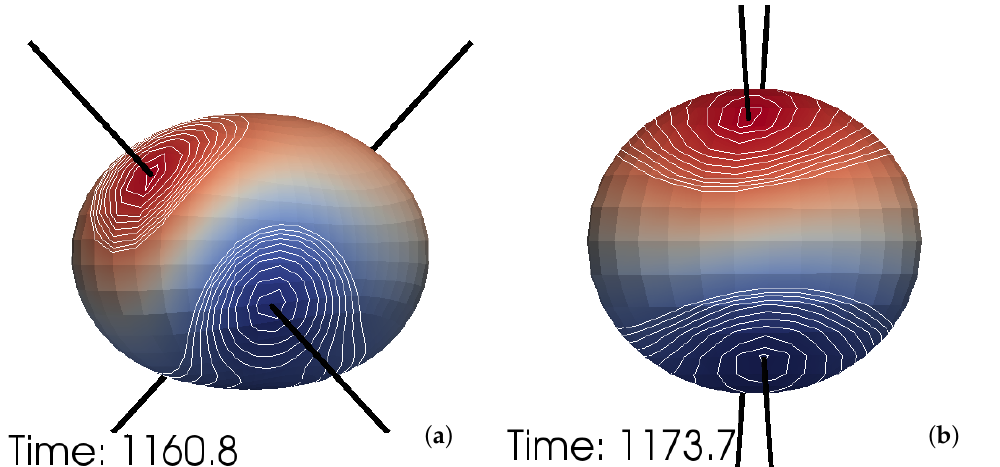
Figure 7. The post-merger (during the merger phase) time evolution of the horizon vorticity B NN for the SK simulation, with ( a , b ) showing two di ff erent times. The white curves are the contours of B NN . We have also drawn black lines connecting the centers of the spin patches for both remnant spins. Over time, the spin patches become more aligned with the J tot